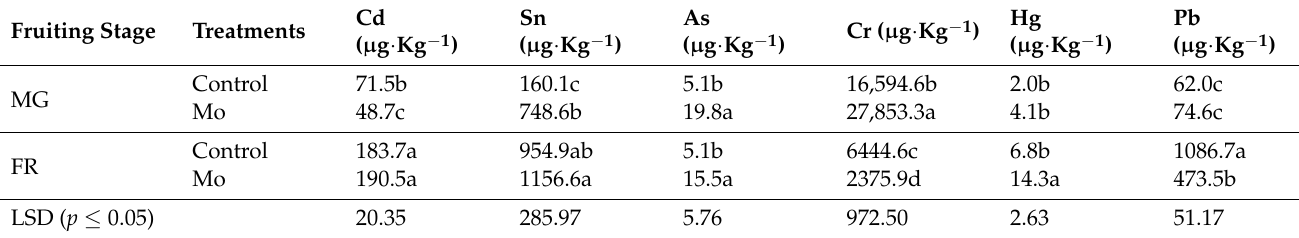
Table 7. Concentrations of heavy metals in fruit peel of loquat affected by the foliar application of molybdenum. Fruiting